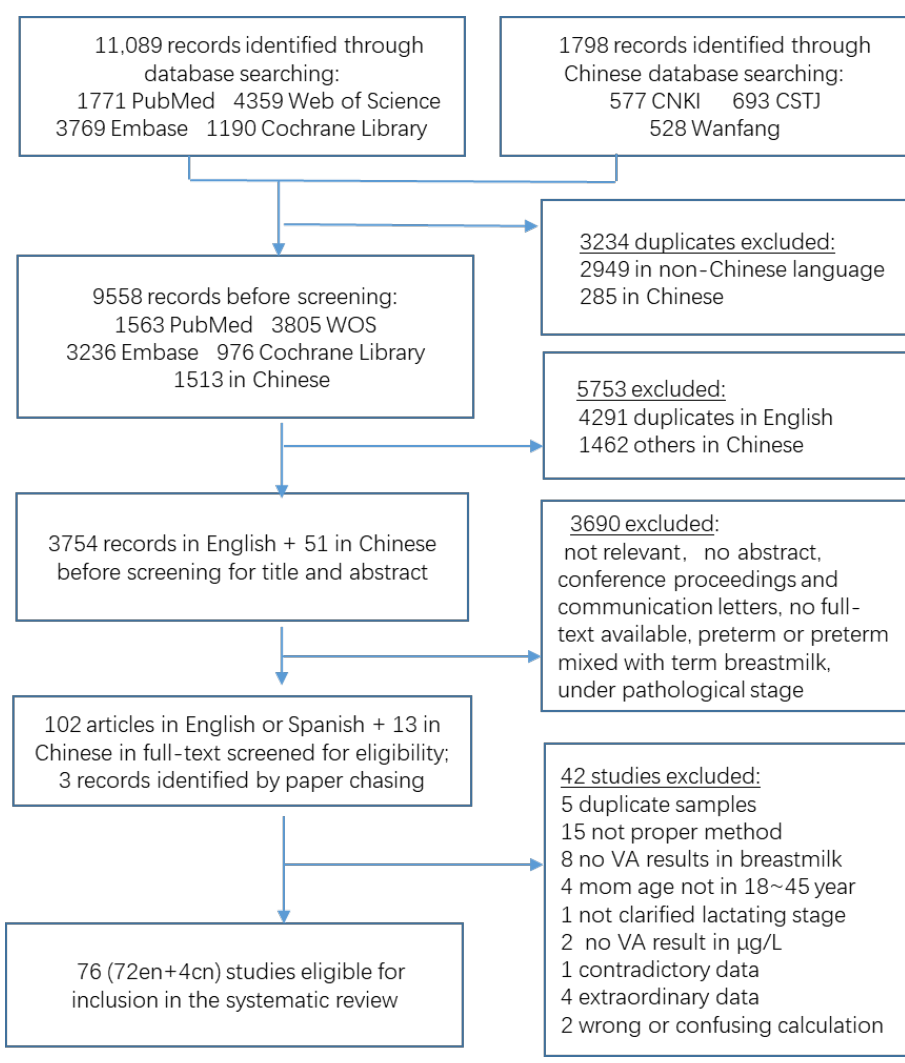
Figure 1. Flow diagram of literature review.